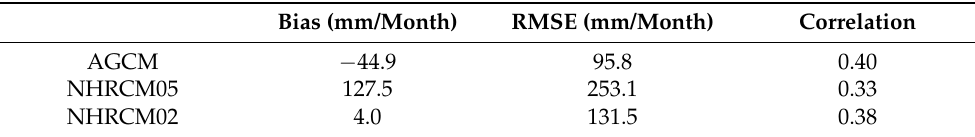
Table 4. Same as in Table 2 but for quantitative evaluation of 20-year mean annual precipitation. See Figure 4 for geographic evaluation.